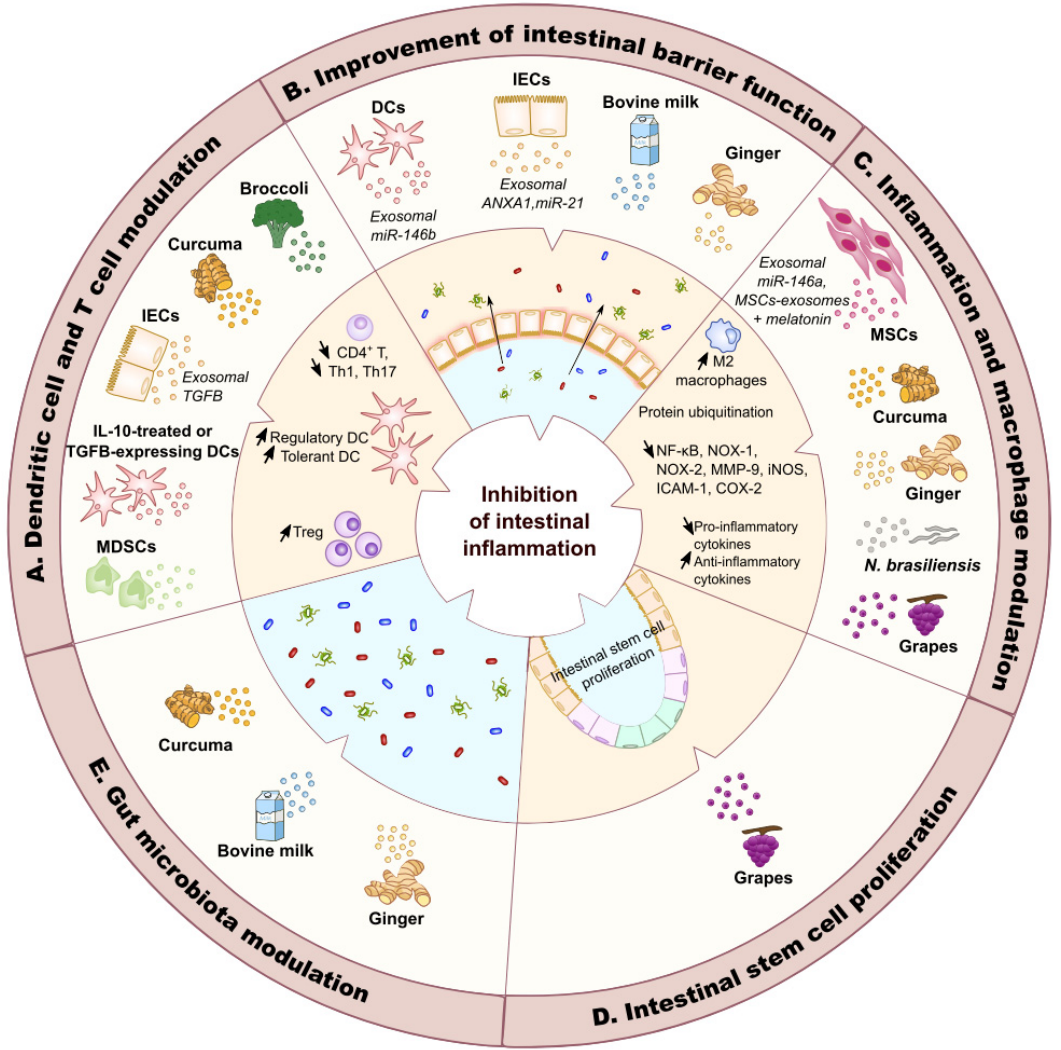
Figure 3. Therapeutic potential of exosomes in IBD. Exosomes derived from human cells, plants or worms have been shown to modulate various cell types and pathways to inhibit intestinal inflammation. A. Exosomes secreted by intestinal epithelial cells (IECs) [101], dendritic cells (DCs) [100] and myeloid-derived suppressor cells (MDSCs) [98] are able to limit the expansion of CD4 + T cells, and of Th1 and Th17 cells. These exosomes and exosomes derived from IL-10-treated DCs or TGF- β -expressing DCs and exosome-like nanoparticles from curcuma increase Treg cell development, while exosomes derived from IECs and exosome-like nanoparticles derived from curcuma favor regulatory DC expansion. Finally, broccoli-derived nanoparticles induce tolerant DCs [102]. Although the components responsible for the effects of exosome-like nanoparticles from curcuma or exosomes from MDSCs and DCs remain to be identified, the effects of exosomes derived from IECs seem to be mediated by exosomal TGF- β . B. Exosomes derived from DCs, IECs and ginger-derived exosome-like nanoparticles may improve intestinal barrier function. While specific ginger exosome-like nanoparticle component(s) involved in these effects have not yet been identified, it was shown that IEC-derived exosomes contain annexin A1 (ANXA1), a protein known to favor intestinal epithelial repair. Upon substance P stimulation, IECs also produce exosomes enriched in miR-21. These exosomes promote cell proliferation and migration, thus improving